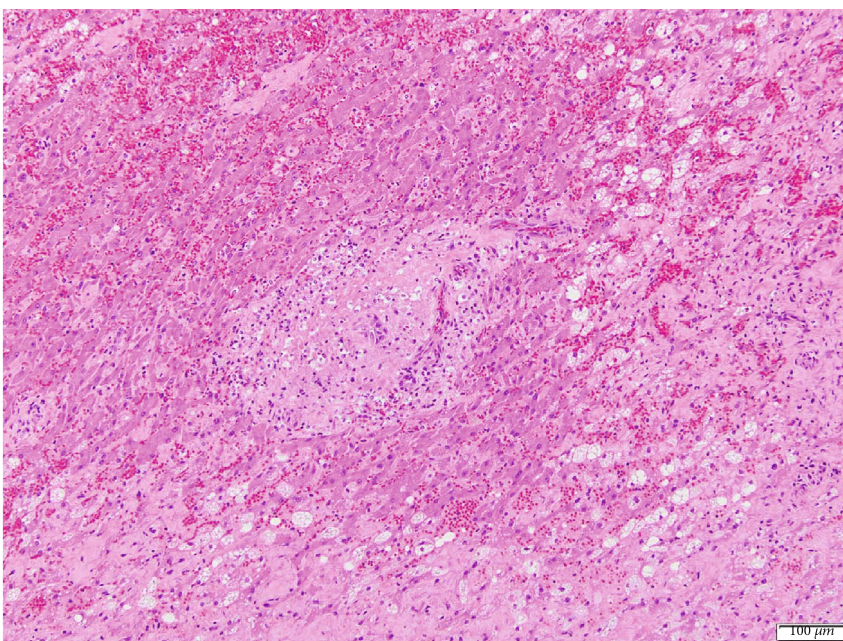
Figure 6: Histopathology of the liver (hematoxylin and eosin stain, 10x). There is complete loss of hepatic cord architecture with widespread biliary and periportal hepatocellular necrosis. Multifocally, hepatocytes are expanded by cytoplasmic vacuolation (hepatocellular lipidosis and/or